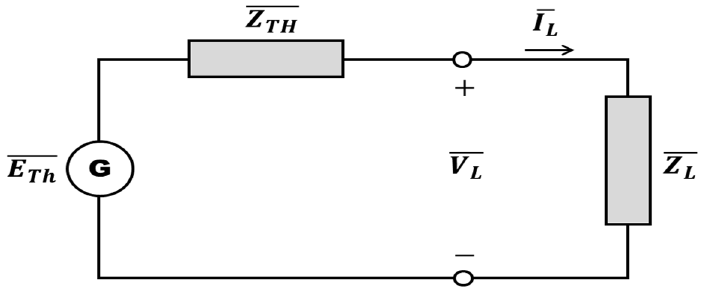
Figure 7. Thévenin equivalent circuit of the power systems. Figure 7. Th é venin equivalent circuit of the power